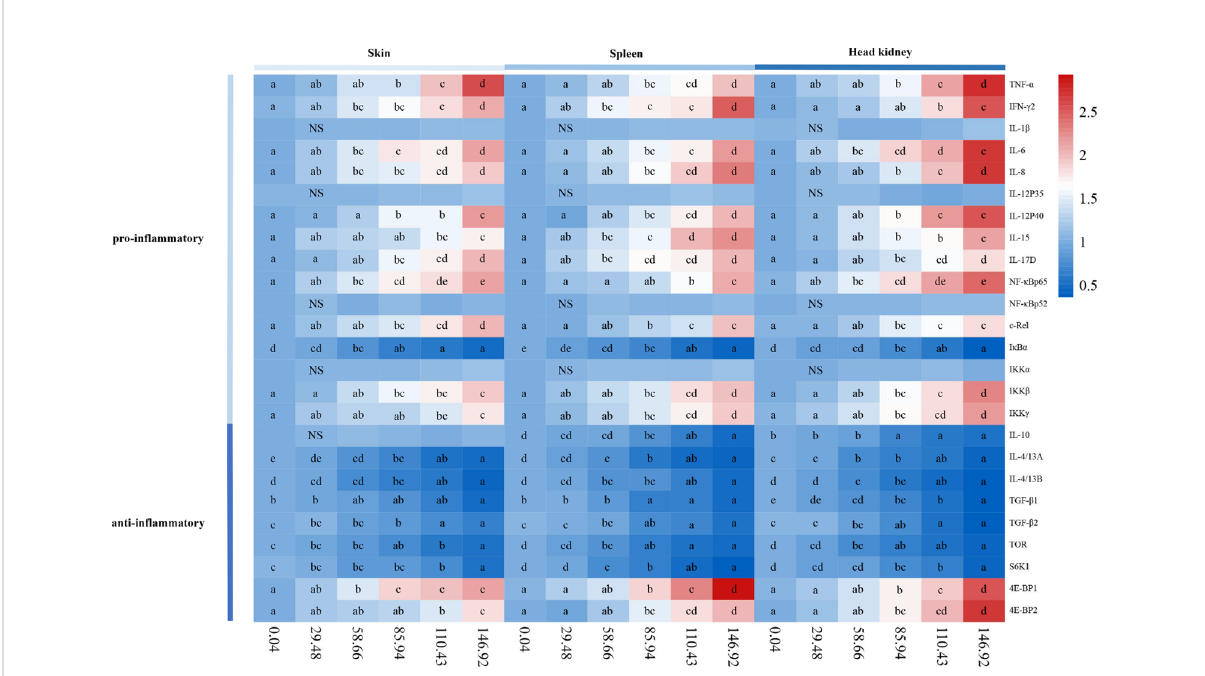
FIGURE 4 Heat-map of AFB1-changed mRNA levels of pro-in fl ammatory cytokines, anti-in fl ammatory cytokines, and in fl ammatory response related signal molecules in skin, spleen and head kidney of grass carp after A. hydrophila infection. n=6 (six fi sh in each group). Different letters indicate signi fi cant differences (P <